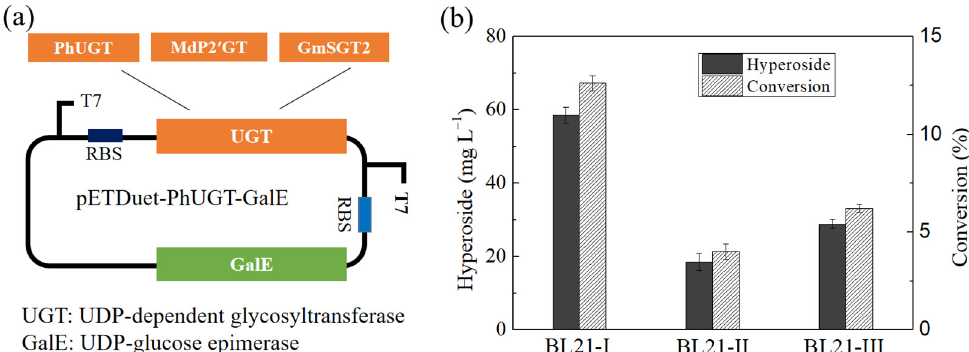
Figure 2. The construction and evaluation of recombinant E. coli. ( a ) The construction of the co-expressed strain with the first T7 promotor, followed by UGT (PhUGT, MdP2 ′ GT, or GmSGT2), and the second T7 promotor, followed by GalE. ( b ) The performance of recombinant E. coli with 302.2 mg·L − 1 quercetin.